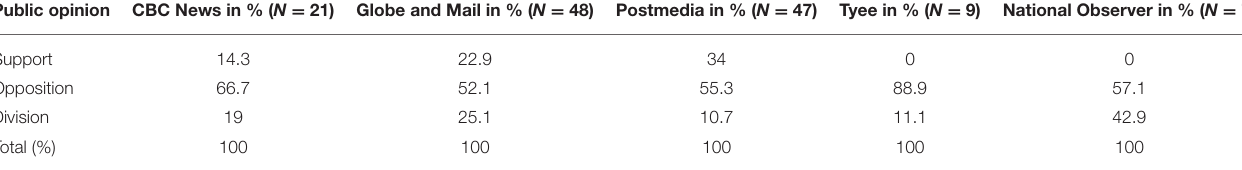
TABLE 8 | Public opinions on